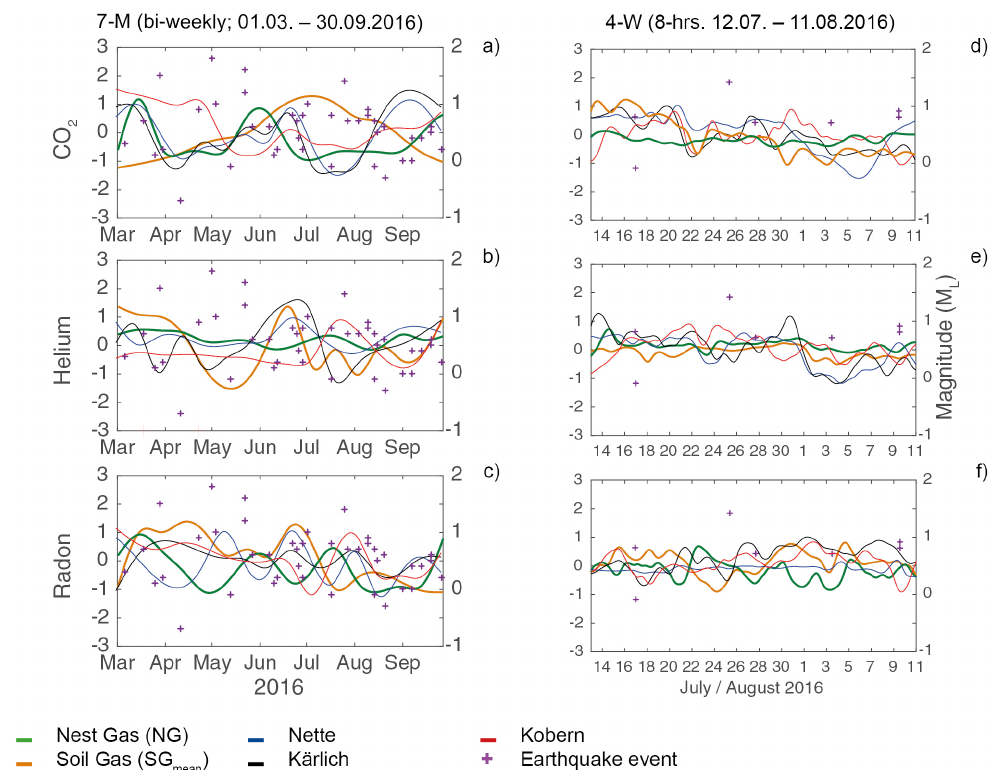
Figure 3. Fluctuation patterns of gas concentrations (centered and scaled data) in ( a ) 7-M and ( b ) 4-W samples in nest gas (NG; green line), soil gas (SG 1-7: SG mean ; orange line), and mineral springs (other colors; from [35]); earthquake events (M L ) are indicated with purple